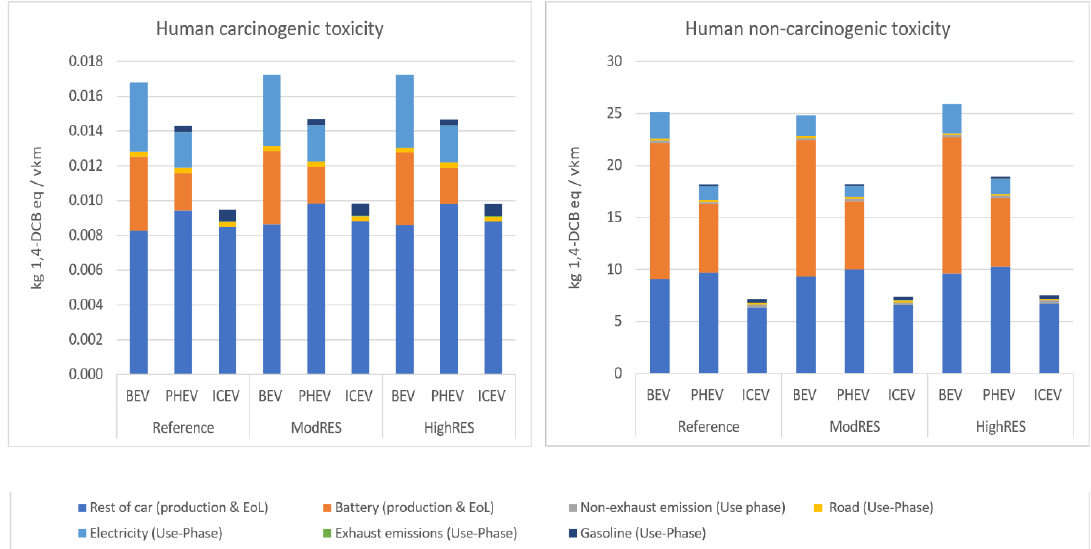
Figure 7. Prospective life cycle assessment results for human carcinogenic toxicity potential and human non-carcinogenic toxicity potential per vehicle kilometer driven in a BEV, PHEV, and ICEV, considering future changes in steel and energy